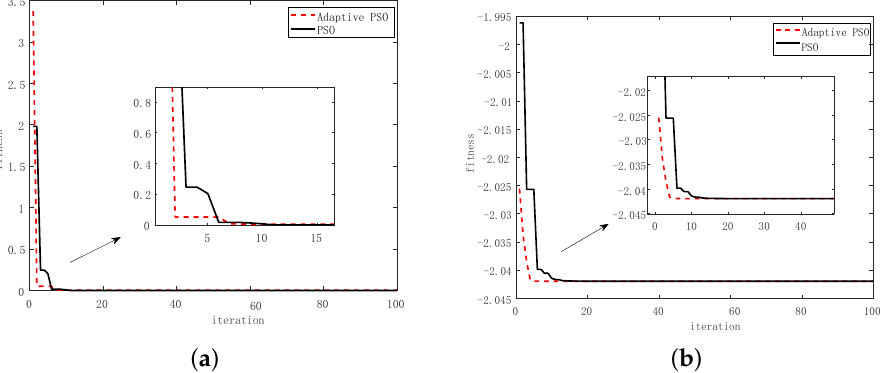
Figure 11. Optimization iteration results of different test functions: ( a ) Rosenbrock test function; ( b ) Griewank test